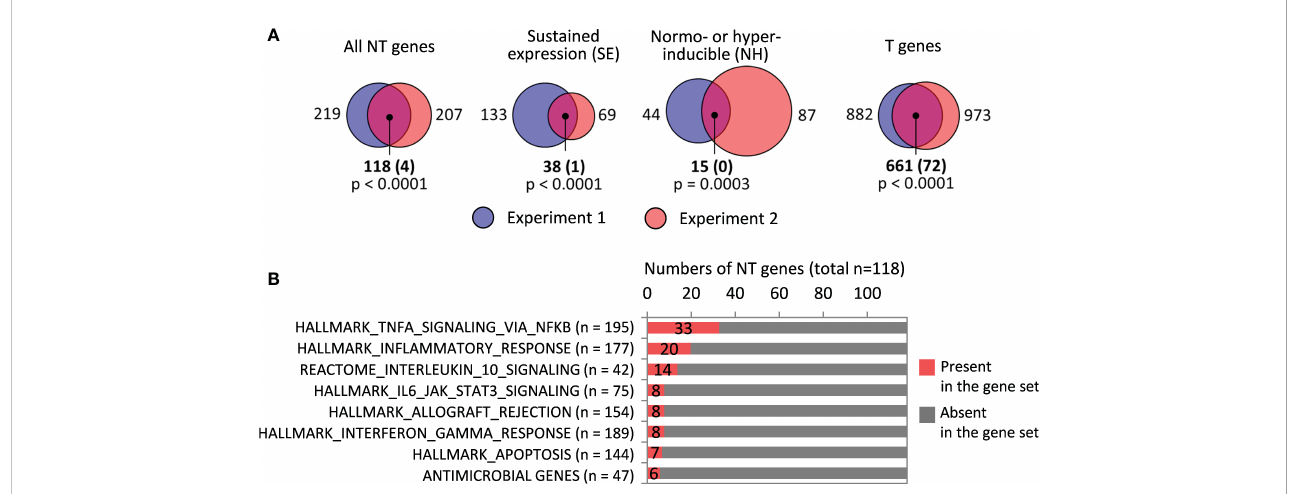
FIGURE 3 Analysis of responses of LPS-tolerized macrophages to LPS restimulation. (A) Sizes of T, NT, SE and NH gene sets identi fi ed in RNA-seq experiments 1 and 2, and their intersections (numbers of genes). Shown in parentheses are expected numbers of coincidences if they were purely random. Differences between expected and actual numbers of coincidences were assessed using c 2 test. (B) Gene sets signi fi cantly over-represented among the 118 NT genes (all with p < 0.001 in c 2